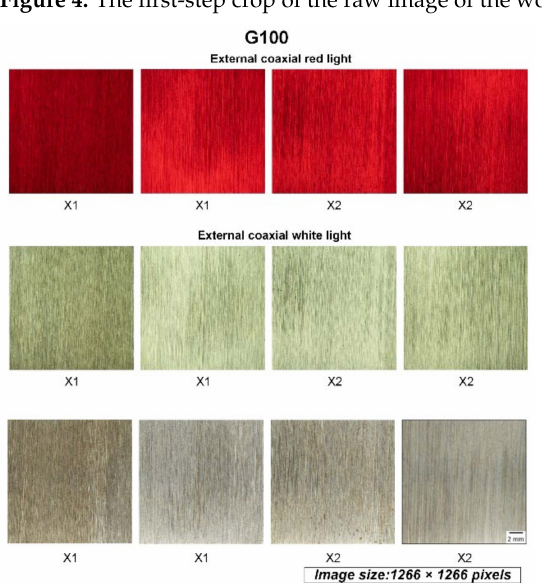
Figure 4. The first-step crop of the raw image of the workpiece.